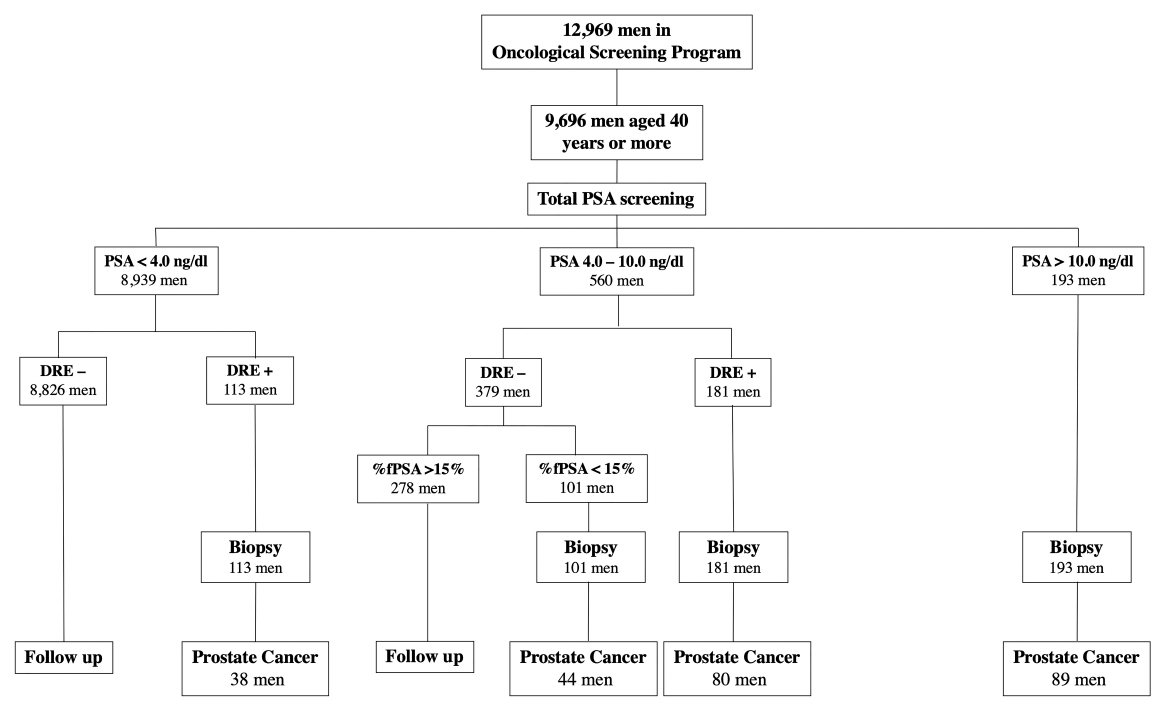
Figure 1 - PSA-screening program